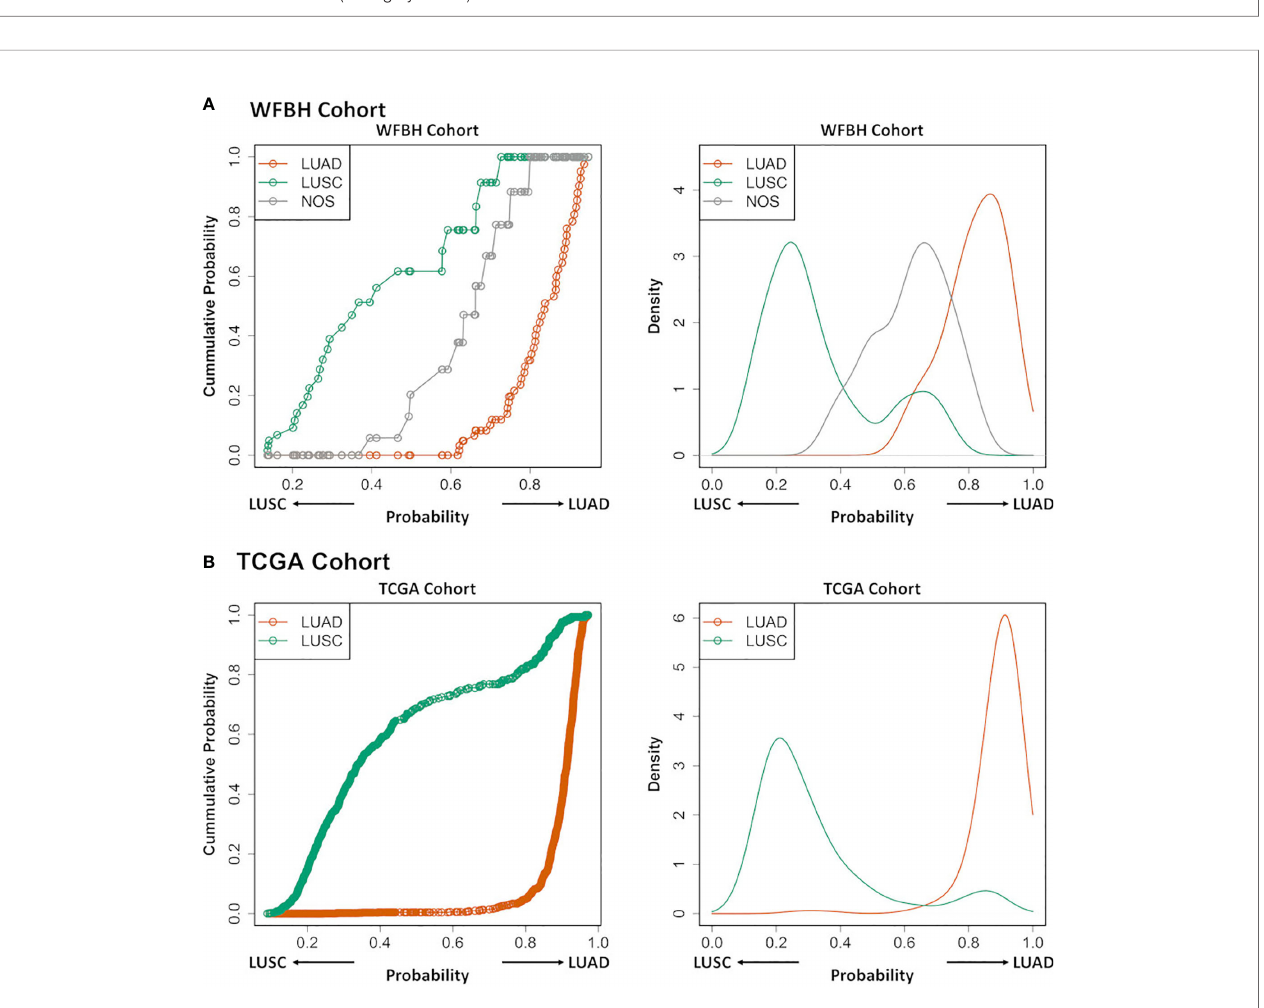
FIGURE 3 | Model performance. The predicted probabilities of subtype LUAD for (A) each FNA samples and (B) each TCGA samples was visualized in the bar plot. Samples classi fi ed as LUAD (p ≥ 0.5) or LUSC (p < 0.5). Signature genes used in the molecular subtyping model were listed according to the absolute values of their logistic regression coef fi cients. The categories of the genes were color coded with respect to the associated subtypes (vermilion for LUAD and bluish green for LUSC). (C) The receiver operating characteristic curves (ROCs) of the model performance on the WFBH FNA, the WFBH tissue bank, and the TCGA cohorts. The corresponding c-statistics (AUC, area under the ROC curve) were 0.986, 0.911, and 0.982, respectively. When the probability threshold is set at q = 0.5, model accuracies are 0.931, 0.881, and 0.945 for the WFBH FNA, the WFBH tissue bank, and the TCGA cohorts, respectively (marked as open circles). The optimal accuracies are reached when optimal q levels are used, which are: 0.958 at q = 0.60 for the WFBH FNA cohort, 0.905 at q = 0.59 for the WFBH tissue bank cohort, and 0.946 at q = 0.68 for the TCGA cohort (solid